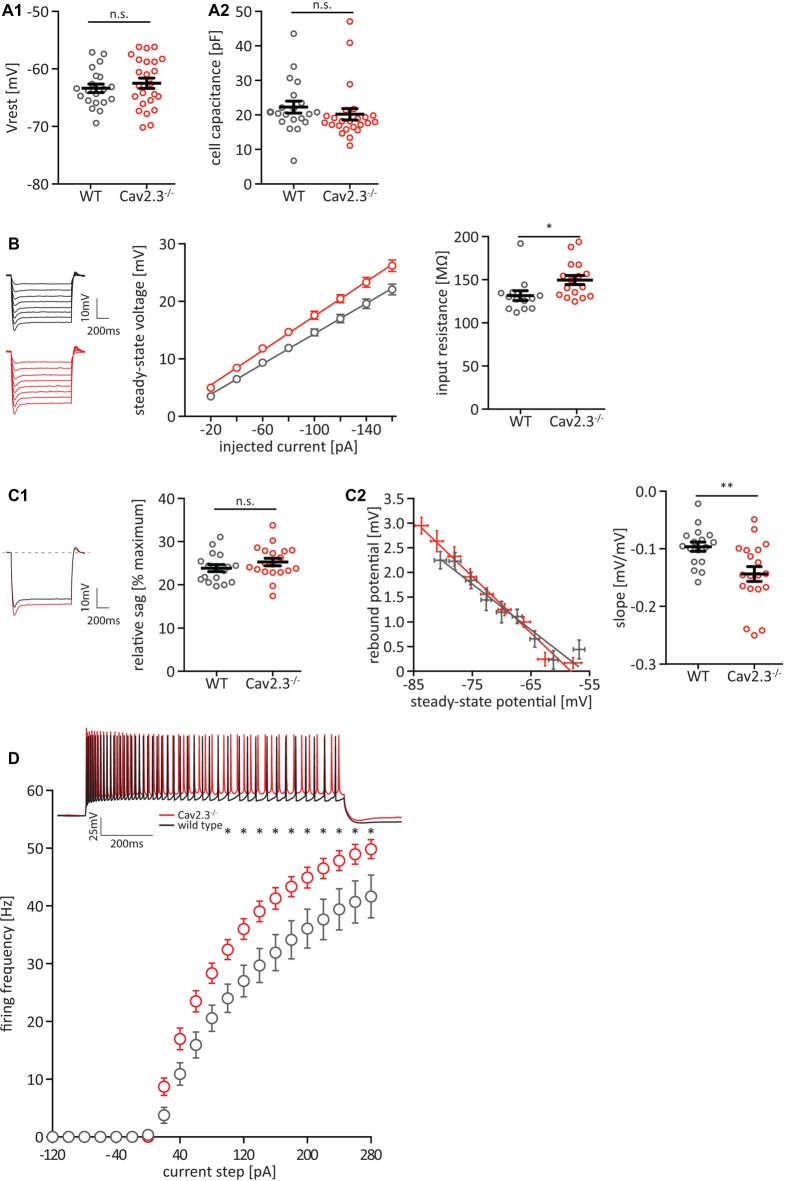
Cav2.3 knockout (KO) CA1 pyramidal cells are hyperexcitable. (A) Resting membrane potential (Vrest; A1) and cell capacitance (A2), measured after break-in. (B) Input resistance quantified as the slope of an IV-curve for hyperpolarizing current steps from −160 to −20 pA. Insets represent averaged voltage traces for wildtype (WT; black) and KO (red) recordings during current injection. (C) Hyperpolarization activated current IH, measured as sag-percentage from maximum voltage deflection (C1) and as the slope of the rebound potential after the end of a series of hyperpolarizing current injections plotted against the steady-state voltage during the current injection (C2). (D) Firing frequency of action potentials (APs) in CA1 pyramidal neurons of Cav2.3 KO and WT animals, elicited by current steps from Vrest, by injection of positive or negative current in steps of 20 pA. Inset shows example recordings for injections of +200 pA WT (black traces) or Cav2.3 KO (red traces). n = 17 for WT, and 21 for KO. All data shown as mean ± SEM, with Student’s T-Test to probe for significance (n.s. = not significant, *p < 0.05, **p < 0.01).